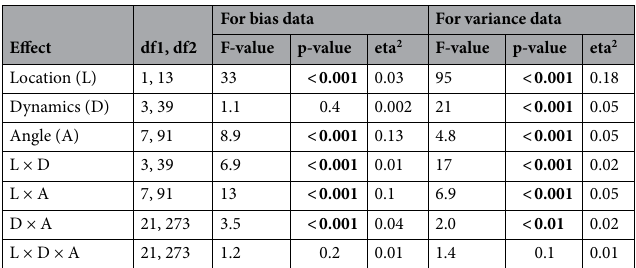
Table 1. Results from the ANOVAs of Experiment